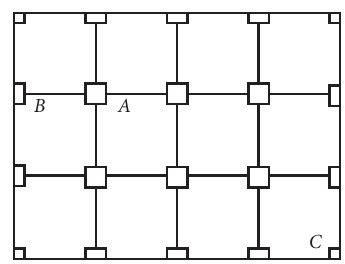
Figure 3: Uniaxially and biaxially loaded